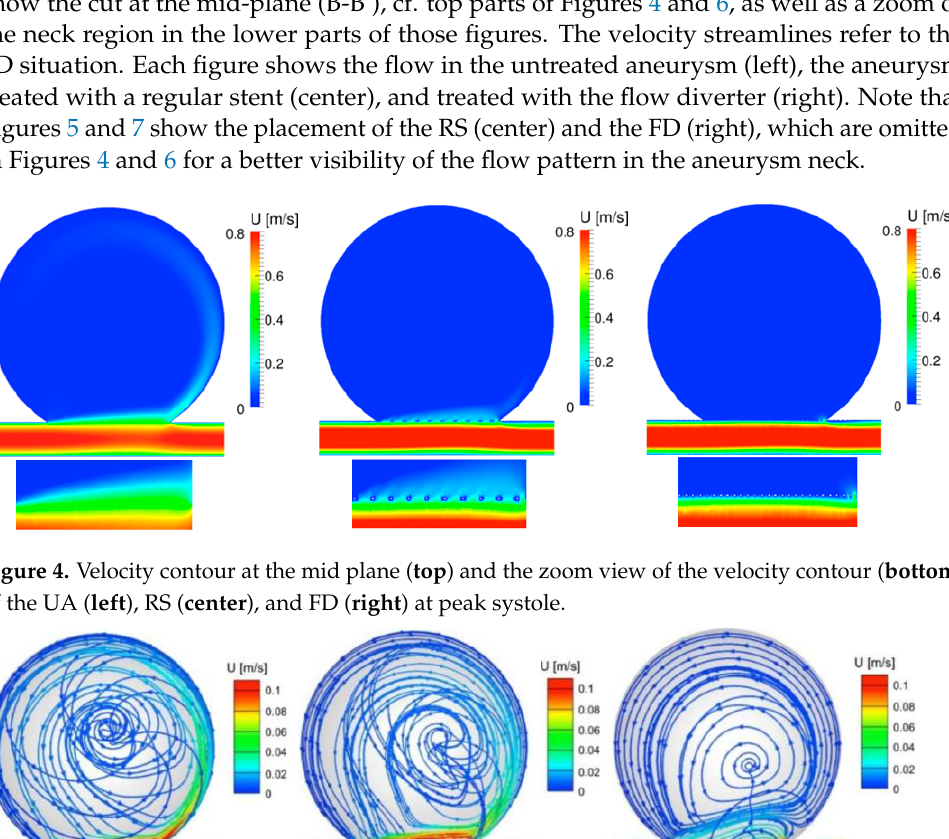
Table 2. WSS for the diastolic cardiac flow.